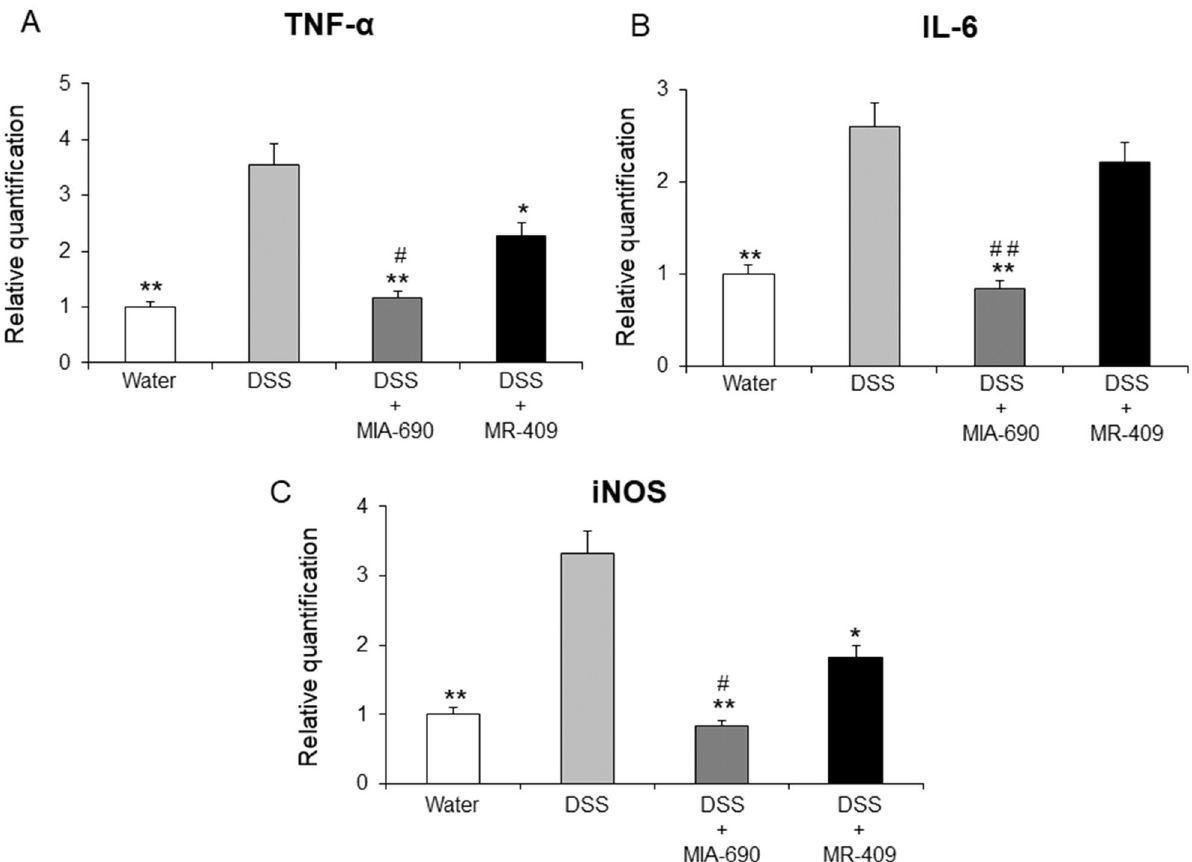
Figure 10. Effects of MIA-690 (5 μg) and MR-409 (5 μg) on relative gene expression of TNF-α, IL-6 and iNOS in colon segment of DSS-treated mice (n = 6 for each group of treatment) as determined by real-time RT PCR. Data were calculated using the 2 −ΔΔCt method; normalized to β-actin mRNA levels and then expressed as relative to control (calibrator sample, defined as 1.00). Data are expressed as means ± S.E.M. and analyzed by analysis of variance (ANOVA) followed by Bonferroni post-hoc test * p < 0.05 and ** p < 0.01 versus DSS treated mice; # p < 0.05 and ## p < 0.01 versus MR-409 treated